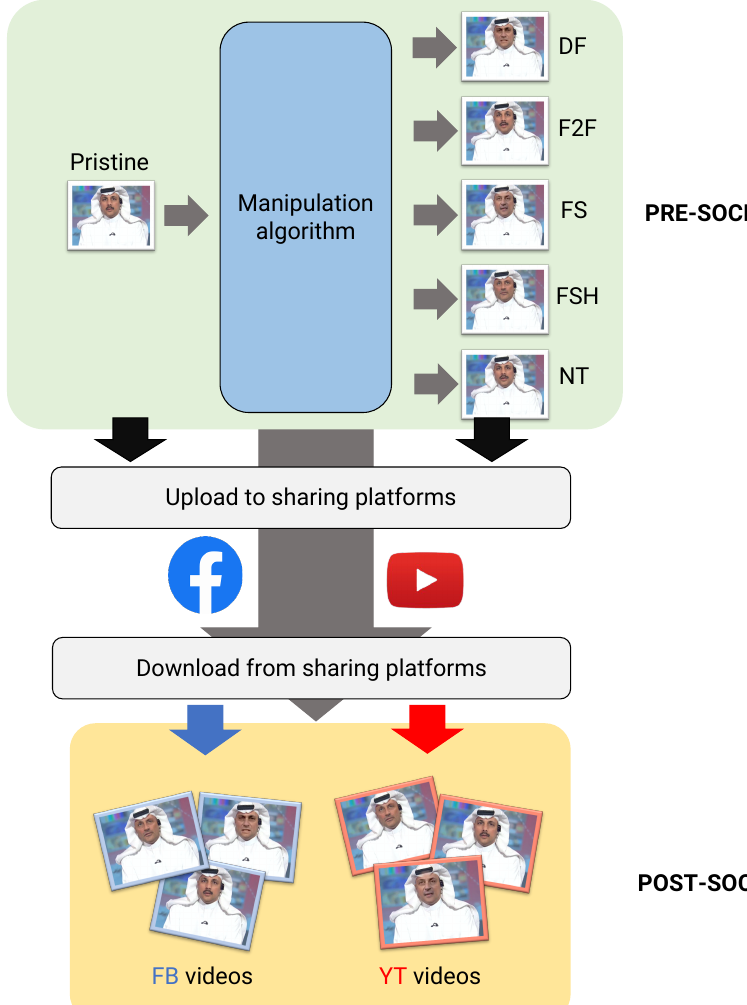
Figure 1. Experimental design of our comparative